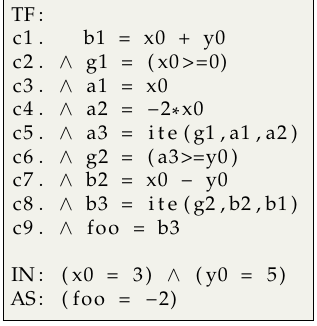
Figure 3. Error trace